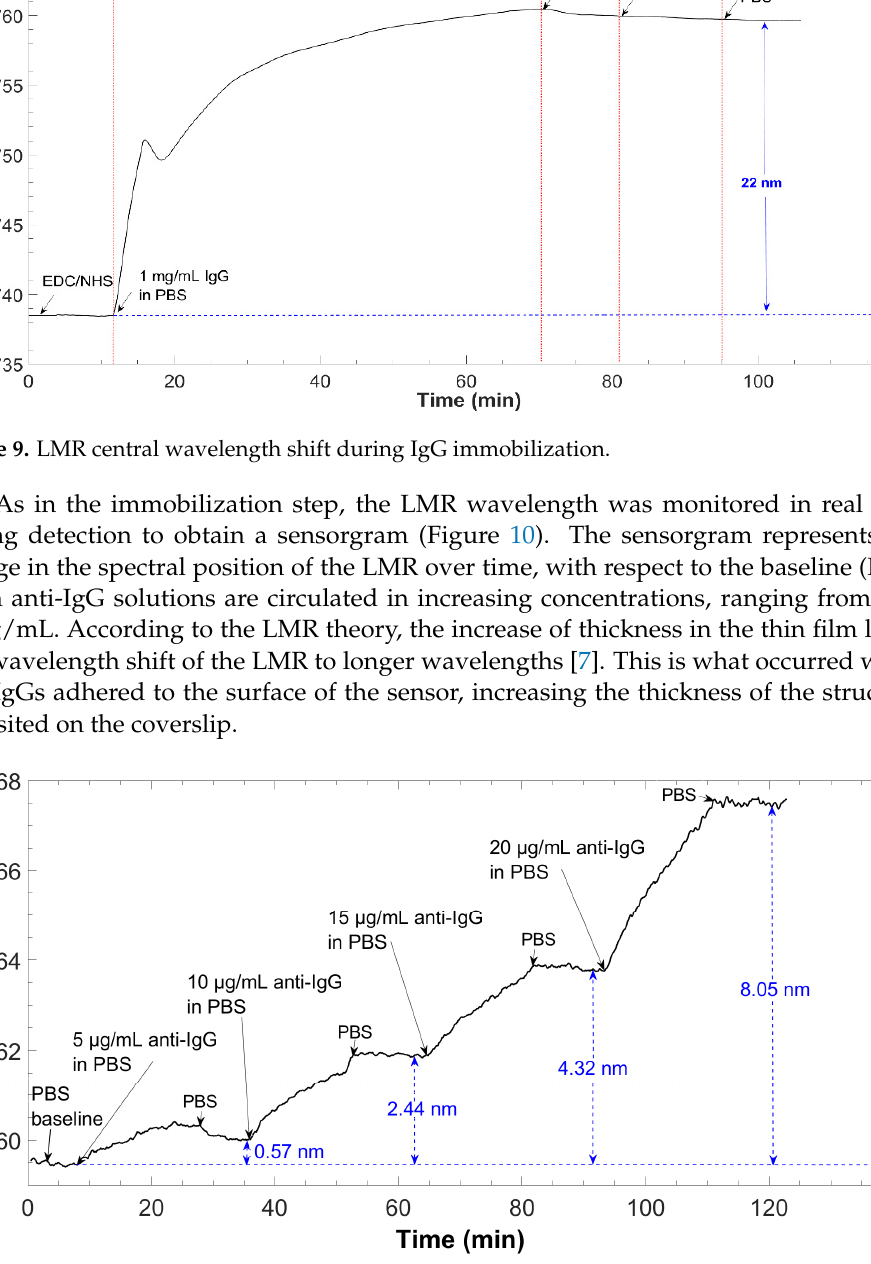
Figure 10. Sensorgram corresponding to the detection of different anti-IgG concentrations, starting from the baseline (blank in PBS buffer) up to 20 μ g/mL of antigen solution.